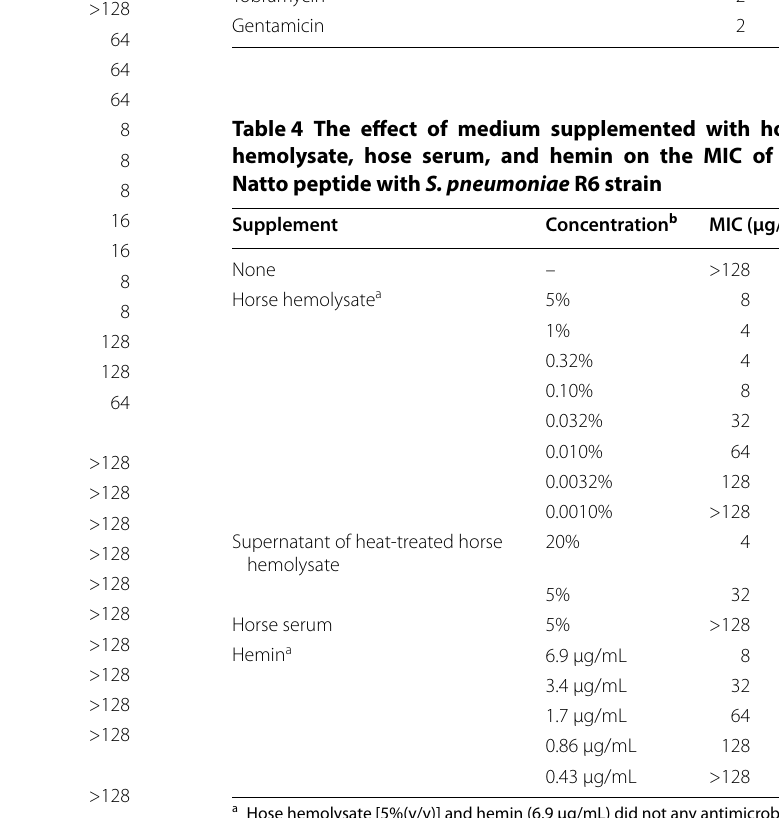
Protein concentrations were adjusted by the results of colorimetric assay as described in “Materials and methods”